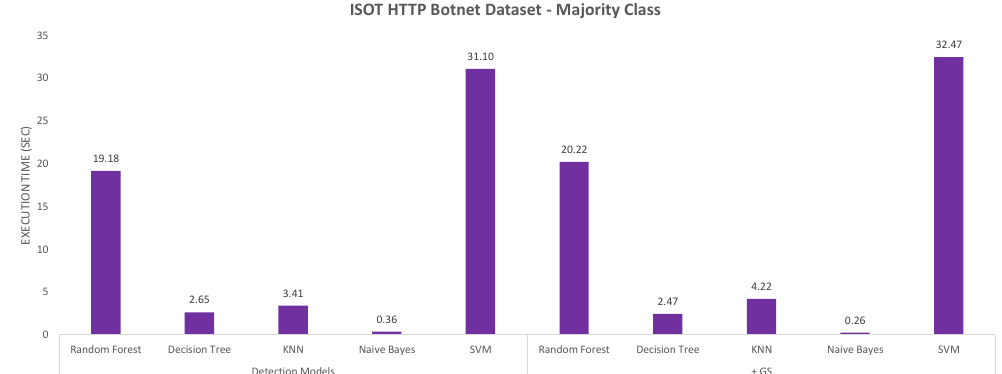
Figure 7. Execution time in the different models with majority class on the ISOT HTTP Botnet dataset.